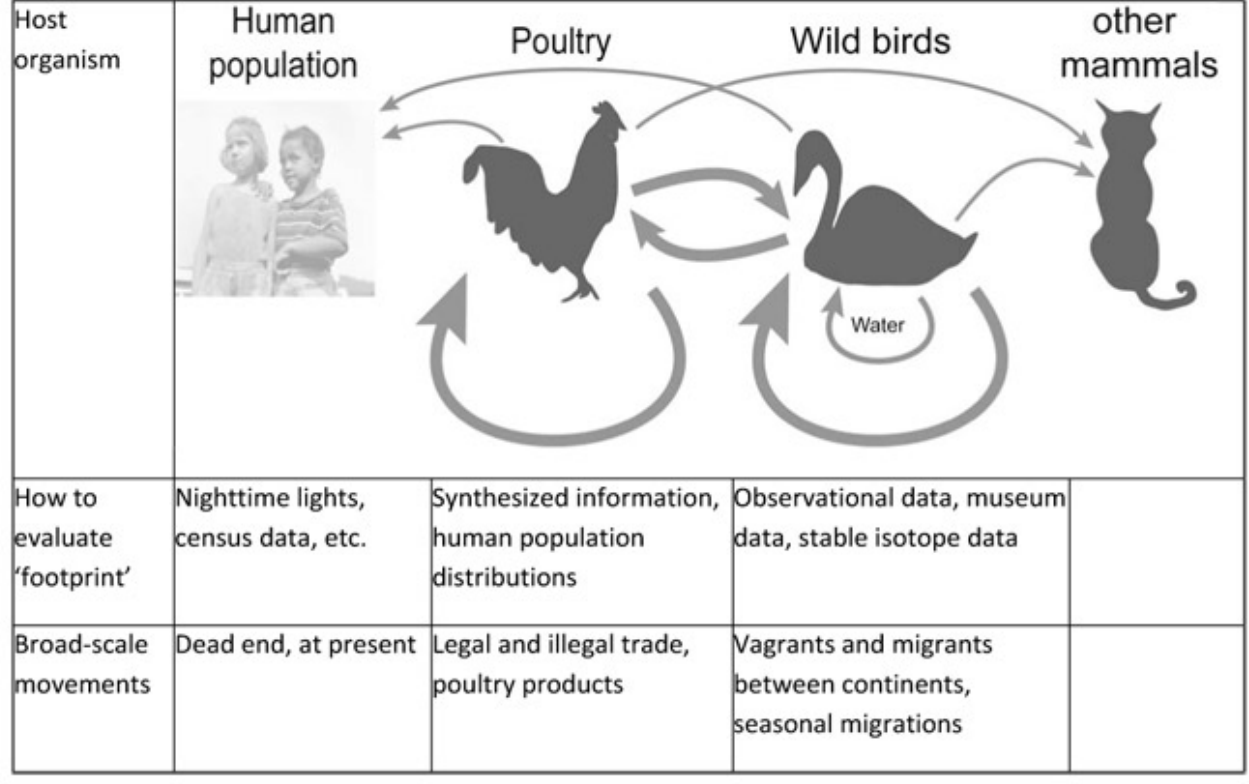
Fig. 1. Diagrammatic summary of transmission routes of avian influenza viruses, showing major transmission routes (thick arrows) and minor transmission routes (slender